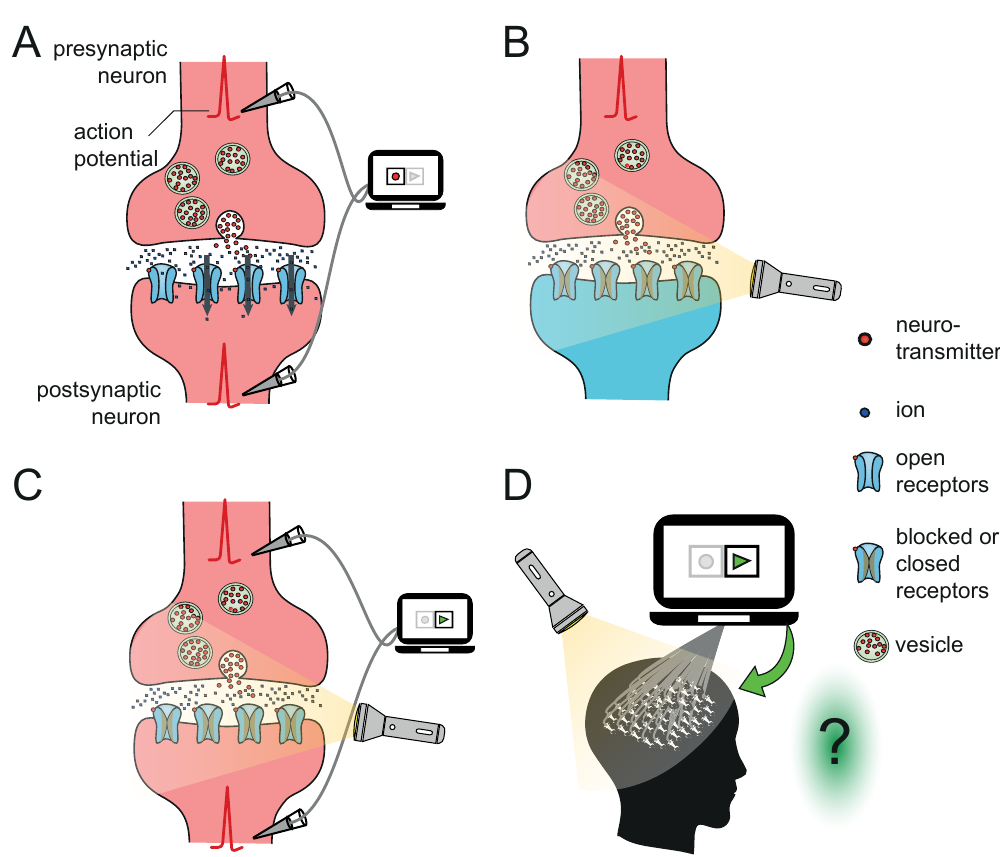
Fig 2. Step 2: Blocking all synaptic transmission in the brain. Normal postsynaptic channel receptors were replaced by light-sensitive (but otherwise identical) postsynaptic channel receptors. Thus, we could use light to block the synaptic transmission optogenetically and, therefore, reversibly disconnect all the neurons from each other. (A) The diagram shows the recording of action potentials (in Step 1) from the pre- and postsynaptic neurons. An action potential at the synaptic terminal of the presynaptic neuron causes vesicles to release neurotransmitters. (B) In Step 2, the permeability of the genetically modified postsynaptic channel receptors is blocked using light. Consequently, action potentials in the presynaptic neurons cannot influence the generation of action potentials in postsynaptic neurons (even when the neurotransmitter binds to the channel receptors). (C, D) The light-induced synaptic disconnection is bypassed when the action potentials recorded in Step 1 are played back into both the pre- and postsynaptic neurons (C) for all the neurons in the participant’s brain (D). Step 3: Physically disconnecting the neurons. Temporal lobe seizures, a common type of